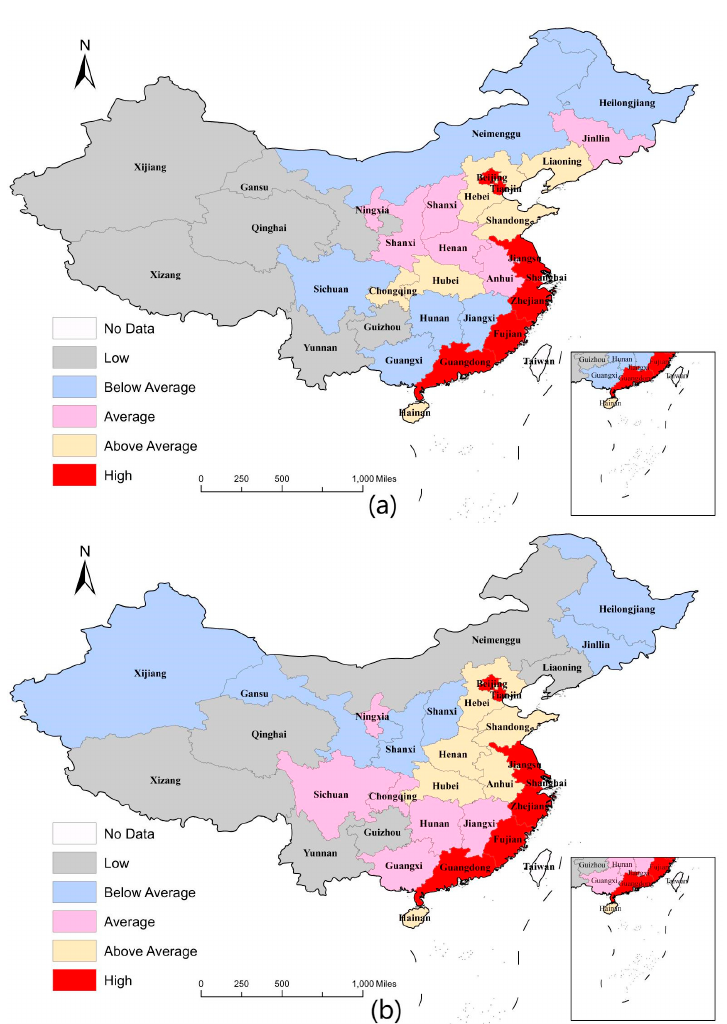
Figure 2. Spatial distribution of digital village construction level in 2011 ( a ) and 2020 ( b ) .